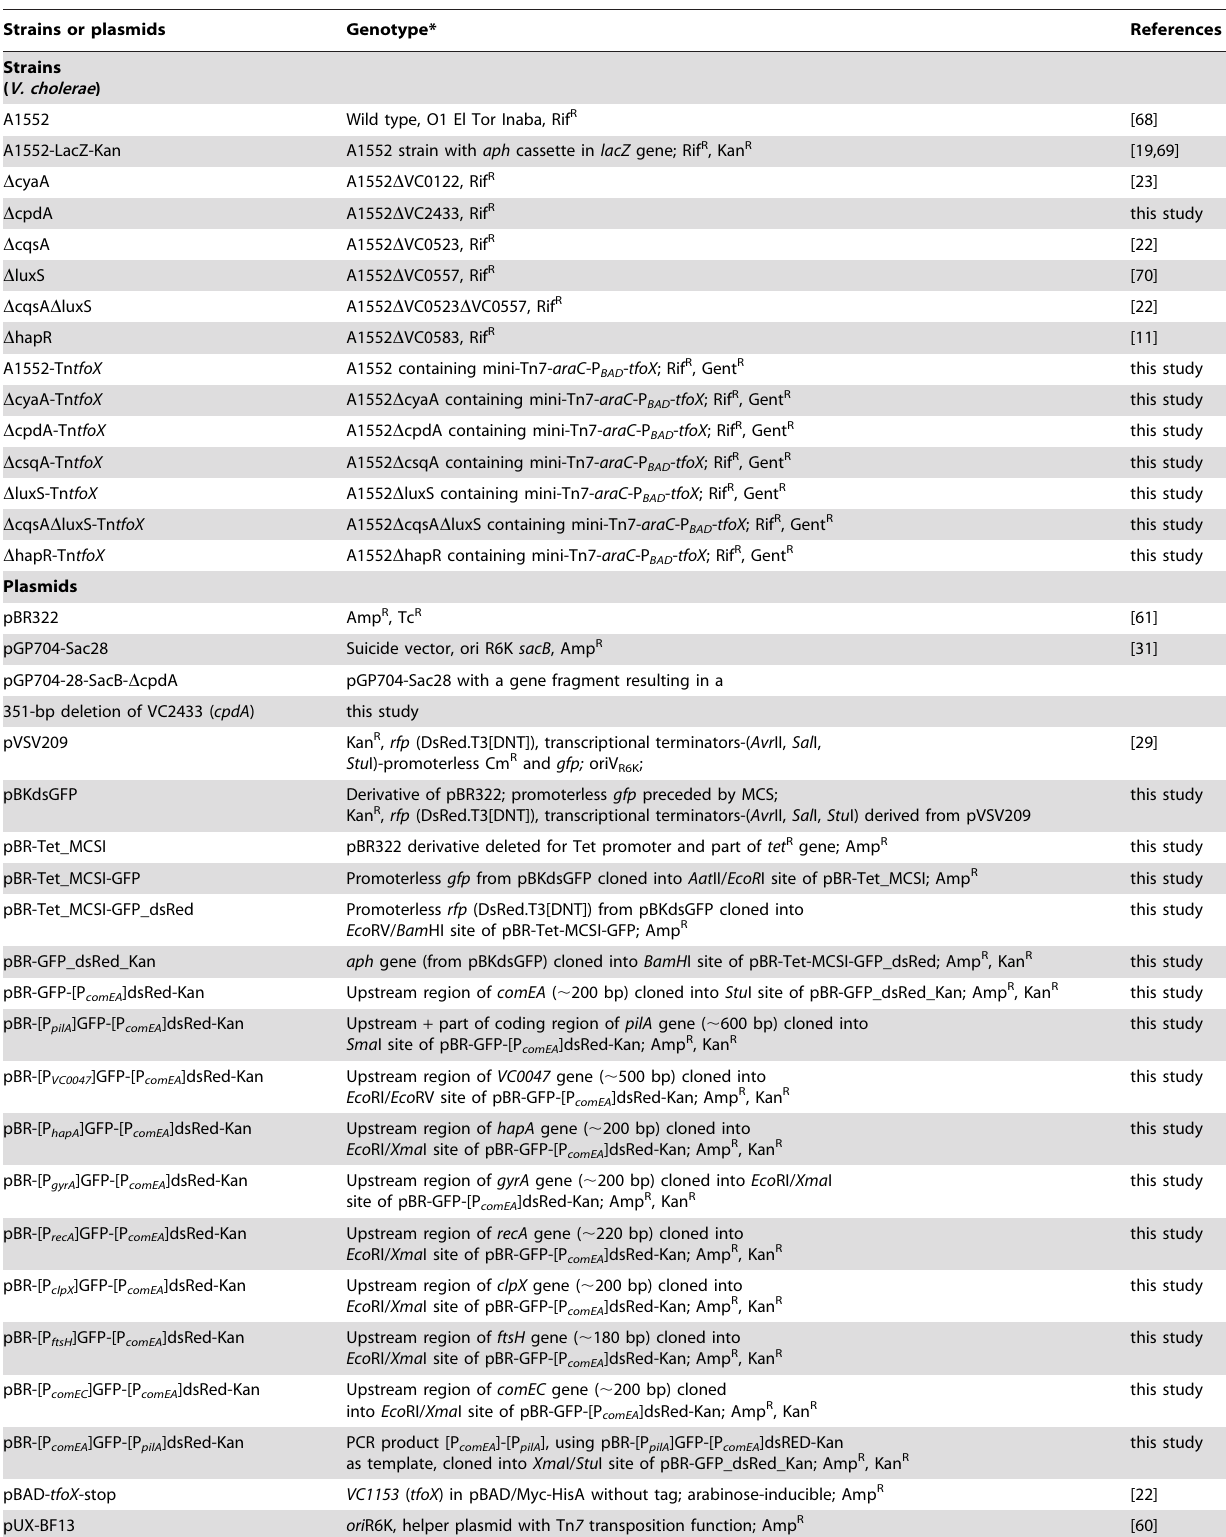
Table 1. Bacterial strains and plasmids.